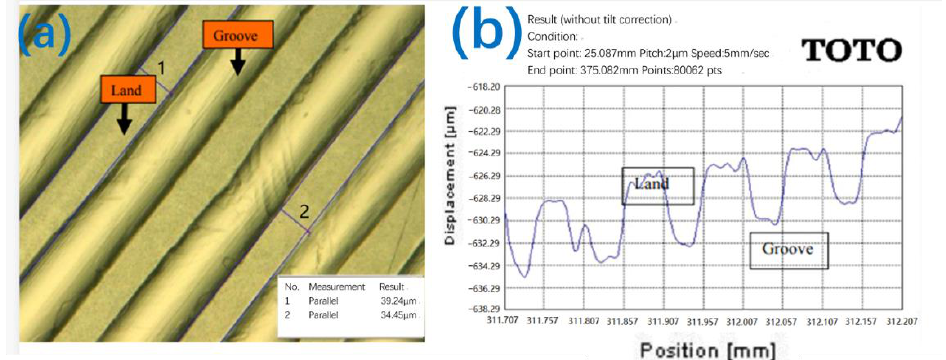
Figure 4. Observation of the surface topography of the lapping plate: ( a ) surface topography; ( b ) surface flatness.